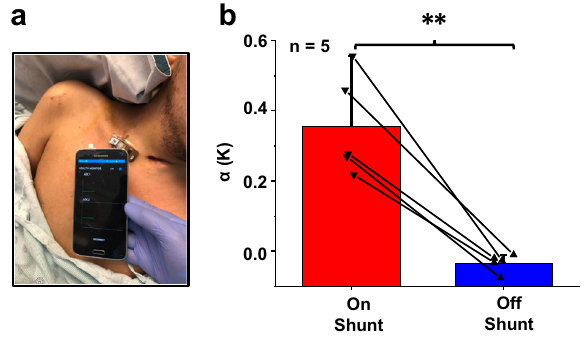
Fig. 4 Short “ spot-check ” measurements on in-patients with con fi rmed fl ow. a Optical image of device mounted on skin location overlying shunt, with smartphone for continuous data readout. b Mean of α computed for n = 5 patients with con fi rmed fl ow, or who are asymptomatic, over on-shunt and off-shunt locations. (** p < 0.01 for paired student- t test). Error bars correspond to standard deviations across fi ve subjects. Participants provided written informed consent to have their photos/images included as a part of this